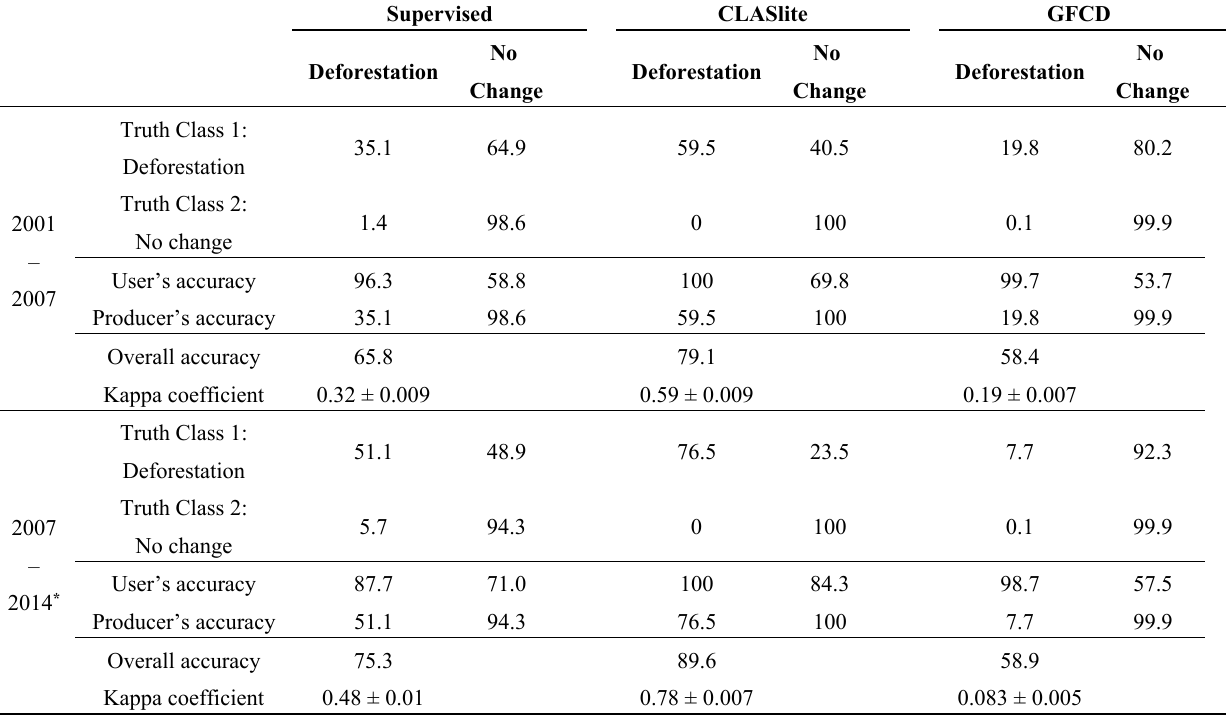
Table A4. Contingency matrices assessing the accuracy of the three forest cover-change maps of Gola and its surrounding 25 km region from 2001–2007 and 2007–2014 * derived from supervised classification in ENVI, classification in the Carnegie Landsat Analysis System lite (CLASlite), and classification from the Global Forest Change dataset (GFCD). Values in the “Truth Class” rows represent percentage of total pixels from the truth class classified into deforestation or no change on the derived maps. For the 2001–2007 change maps, 3471 total pixels were identified in the deforestation truth class and 3265 total pixels were identified in the no change truth class. For the 2007–2014 change maps, 4004 total pixels were identified in the no change truth class and 3159 total pixels were identified in the deforestation truth class. All accuracy values are presented as percentages. Kappa coefficients are reported ± one standard